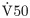
Flow-volume curves observed during mechanical ventilation.A: An example of a flow-volume curve recorded during general anesthesia. Its descending limb appears almost linear during mechanical ventilation. B: A schematic diagram of a flow-volume curve during mechanical ventilation. The interval connecting the points that correspond to the flow rates at 50% and 25% of tidal volume (expressed as V˙’50 and V˙’25, respectively) is displayed as a red line segment.